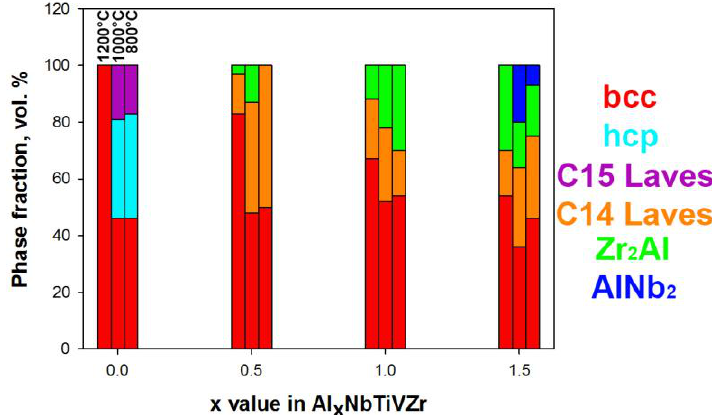
Figure 7. Fractions of the constitutive phases of the Al x NbTiVZr ( x = 0; 0.5; 1; 1.5) alloys after annealing at 1200 °C for 24 h and at 800 °C and 1000 °C for 100 h.